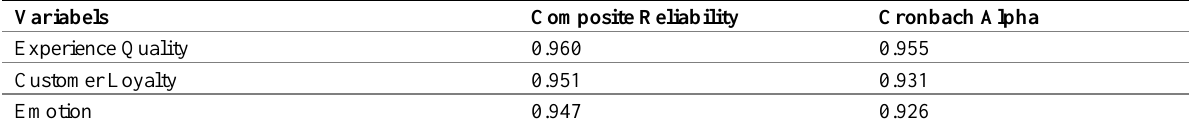
Table 1: Composite Reliability, Cronbach Alpha,